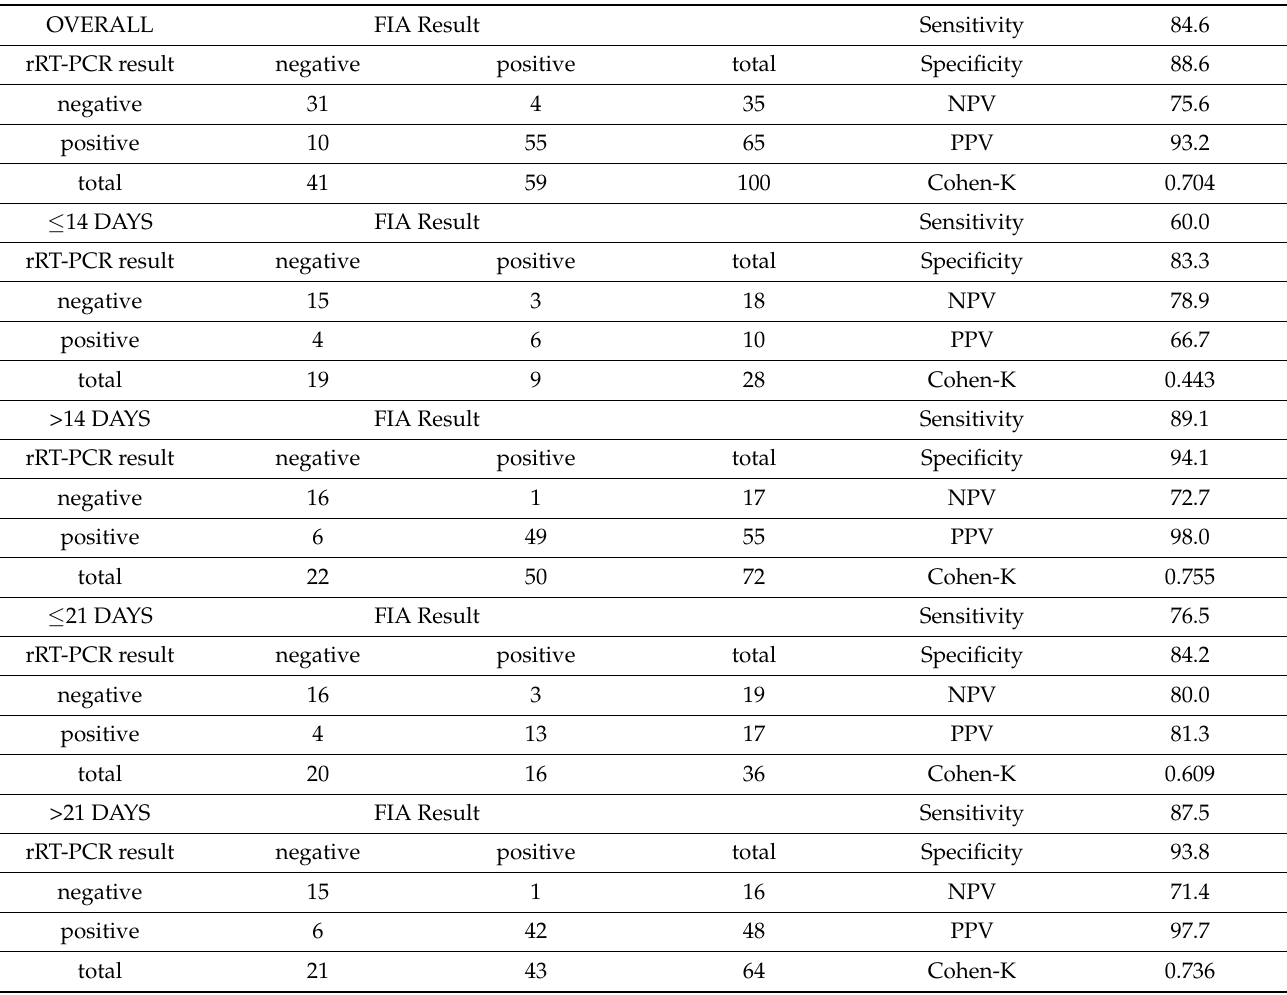
Table 4. Analytical performance of FIA compared with the gold standard biomolecular (and clinical) diagnosis of COVID-19.